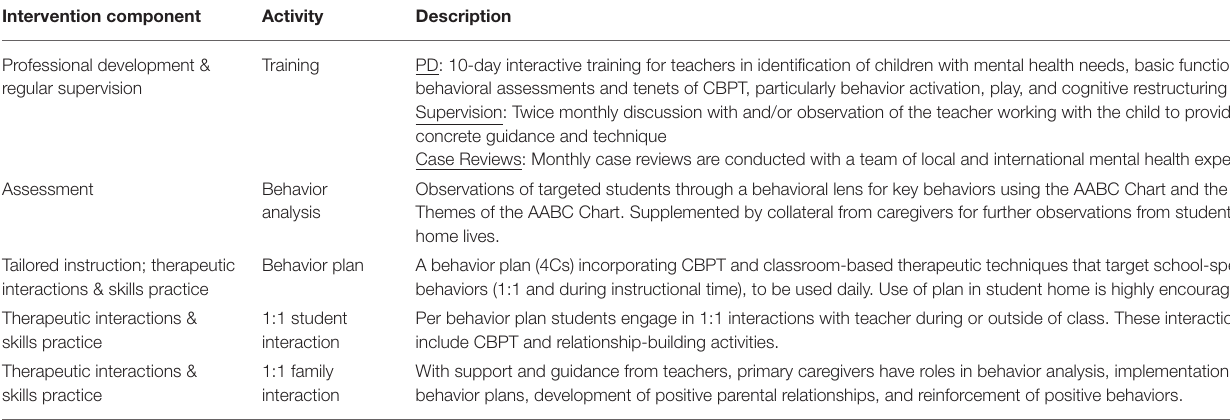
TABLE 1 | Core intervention